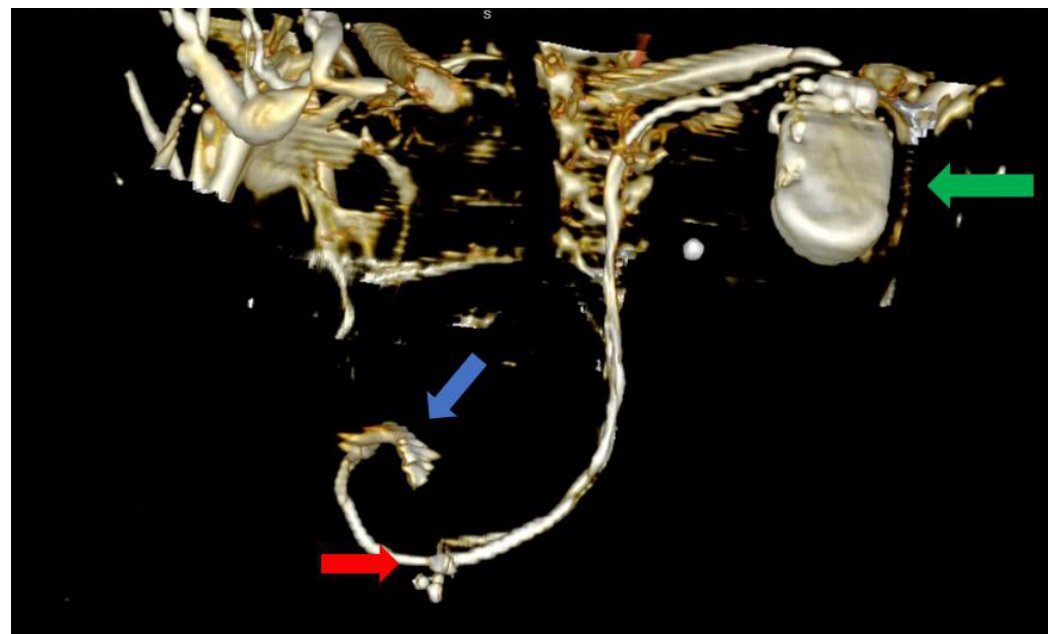
Figure 5. Computer tomography showing an anterior view with the soft tissue removed from the image, as well as most of the skeleton. The image clearly shows the impulse generator (green arrow), the right ventricular lead implanted in the right ventricle forming a loop (blue arrow), as well as the tetrapolar CS lead adjacent to the right ventricle; the lead had migrated from its initial position in the CS (red arrow).